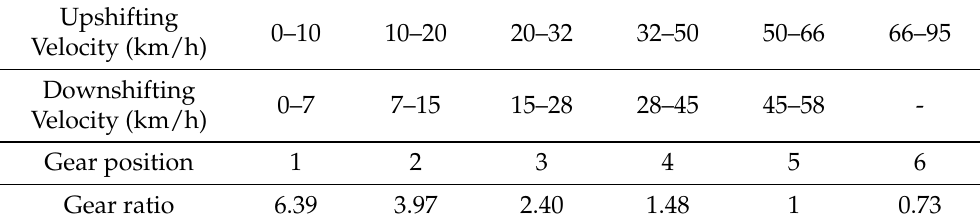
Table 2. The AMT gearbox parameters.